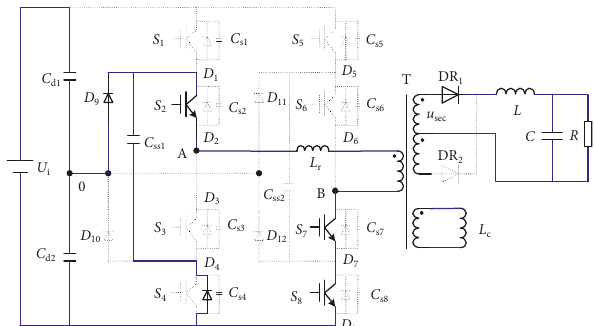
Figure 10: Equivalent circuit of mode 2.